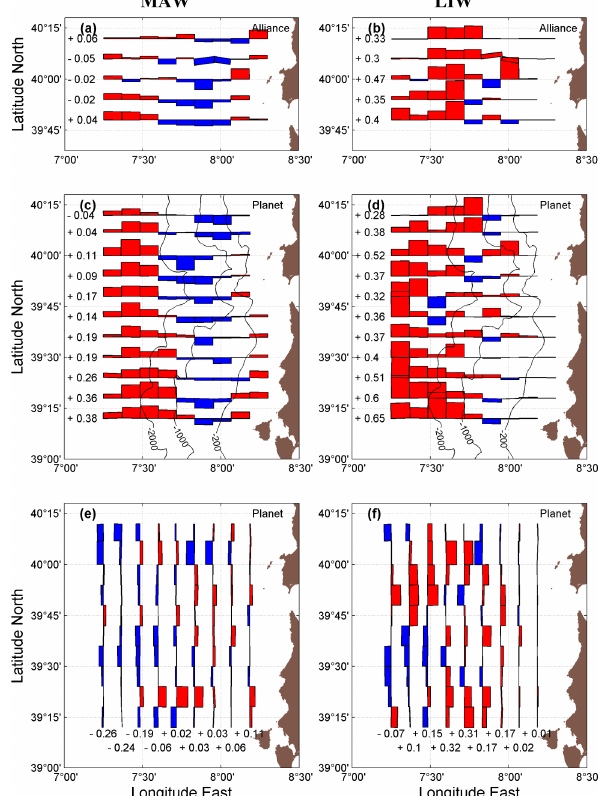
Figure 13. Geostrophic transports (Sv) calculated with a level of no motion (LNM) at 1000dbar and bottom, respectively, along the CTD transects of (a, b) Alliance and (c, d, e, f) Planet within the water masses (a, c, e) MAW and (b, d, f) LIW. The net transports are noted beside each transect. Plots of the meridional transports observed by Planet additionally show the isobaths at 200, 1000, and 2000m